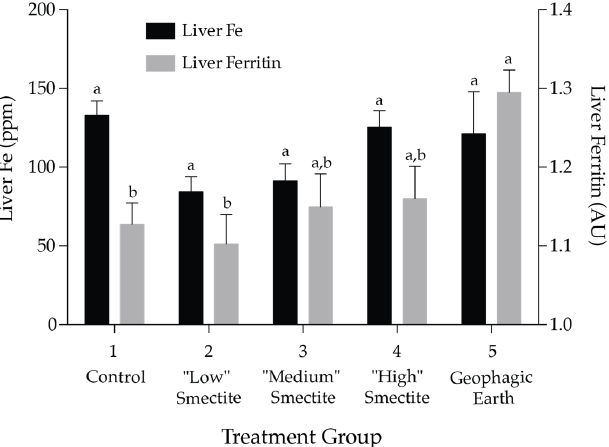
Figure 1. Liver ferritin and liver Fe at day 28. Ferritin levels are means ( n = 4, ± SEM) and are expressed relative to a standard of horse spleen ferritin as arbitrary units (AU). Liver Fe levels are means ( n = 10 ± SEM). Means without a common letter are significantly different at p < 0.05 (Tukey’s honest significant difference (HSD)).